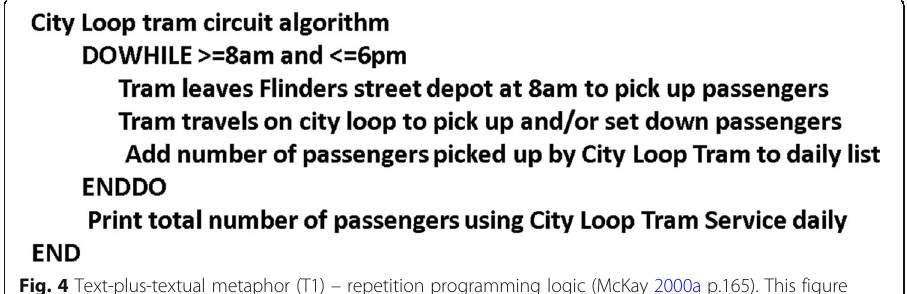
Fig. 4 Text-plus-textual metaphor (T1) – repetition programming logic (McKay 2000a p.165). This figure represents a textual metaphor for a ‘ do while loop ’